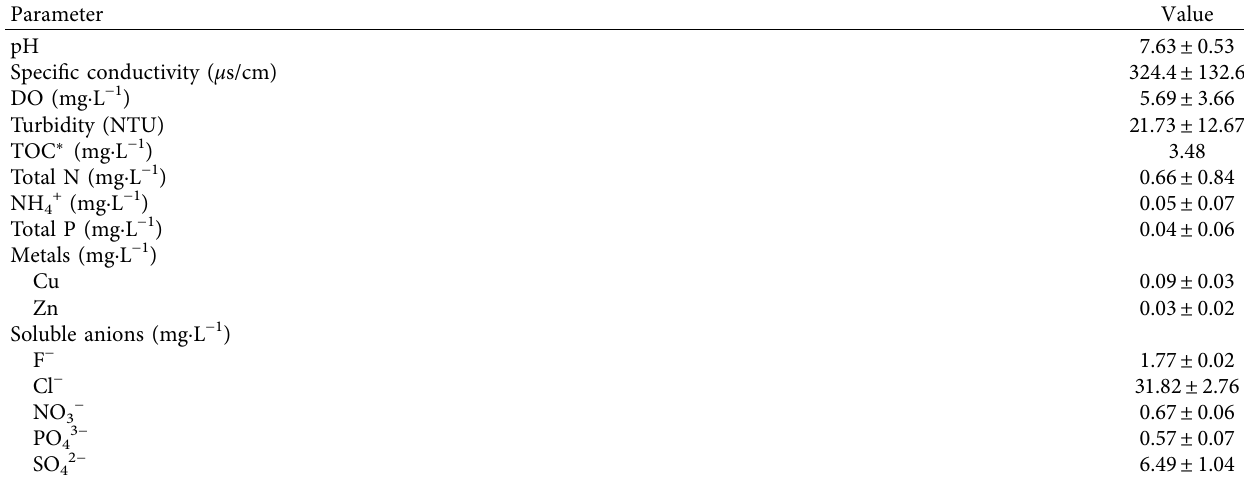
Table 2: Selected chemical and physical properties of the reservoir water used in this study.